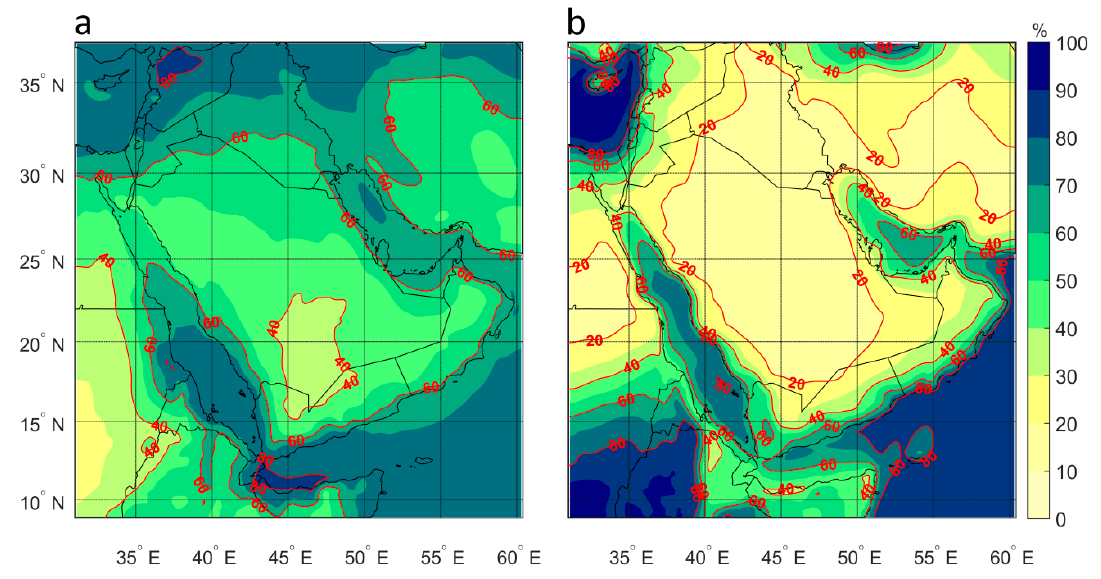
Figure 11. Mean relative humidity for the months ( a ) January and ( b ) July.